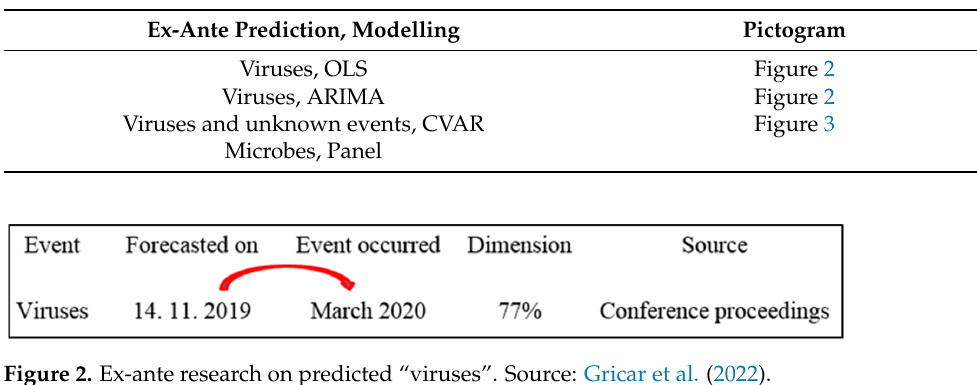
Figure 2. Ex-ante research on predicted “viruses”. Source: Gricar et al. (2022).